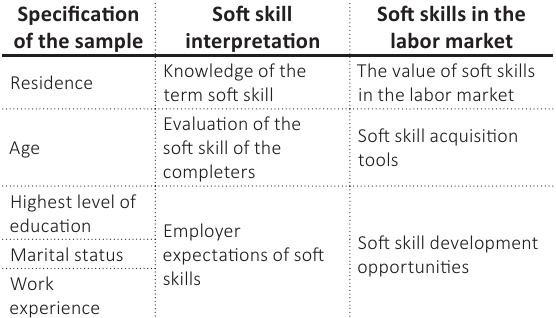
Table 1. Structure of the questionnaire